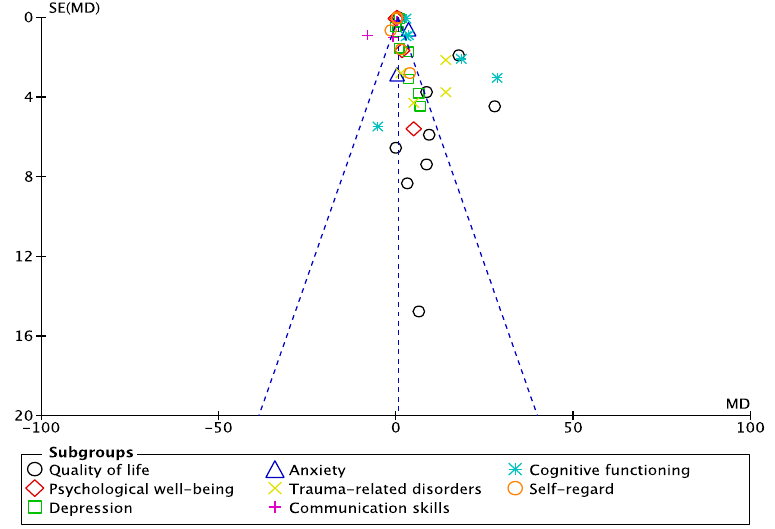
Figure 6. Funnel plots for visual assessment of the presence of publication